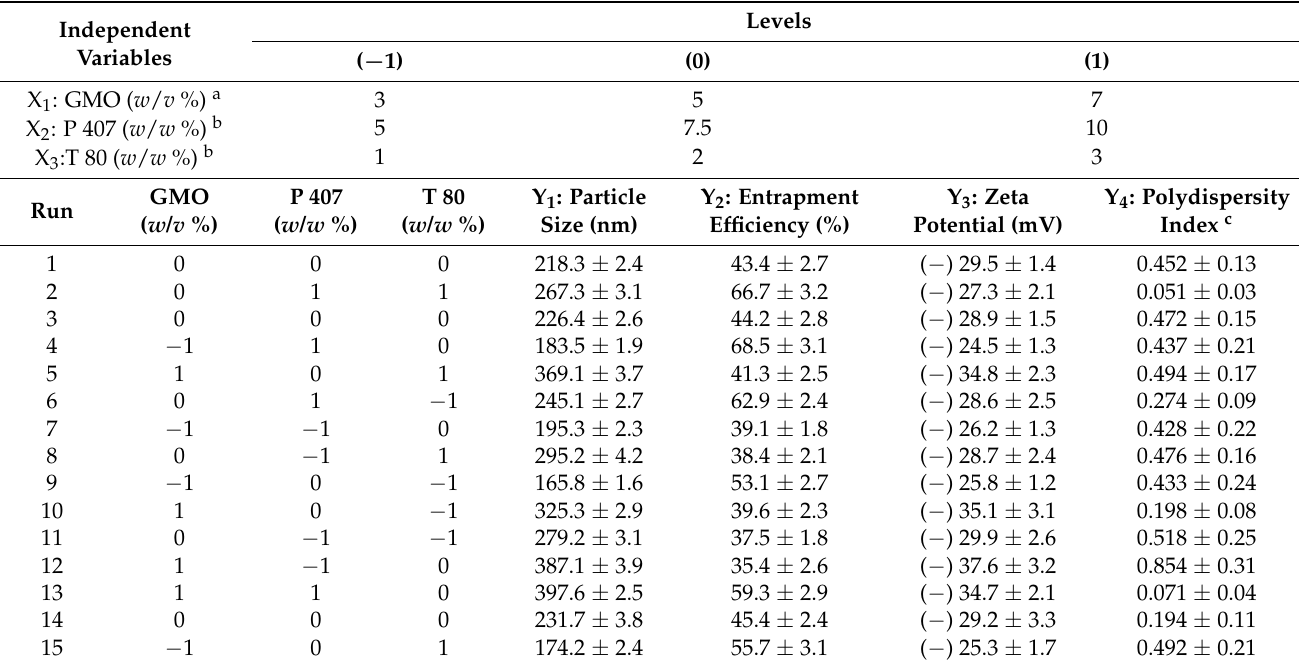
Table 1. Independent variables, experimental runs, and response variables for the formulations of GS-CBS according to the Box–Behnken